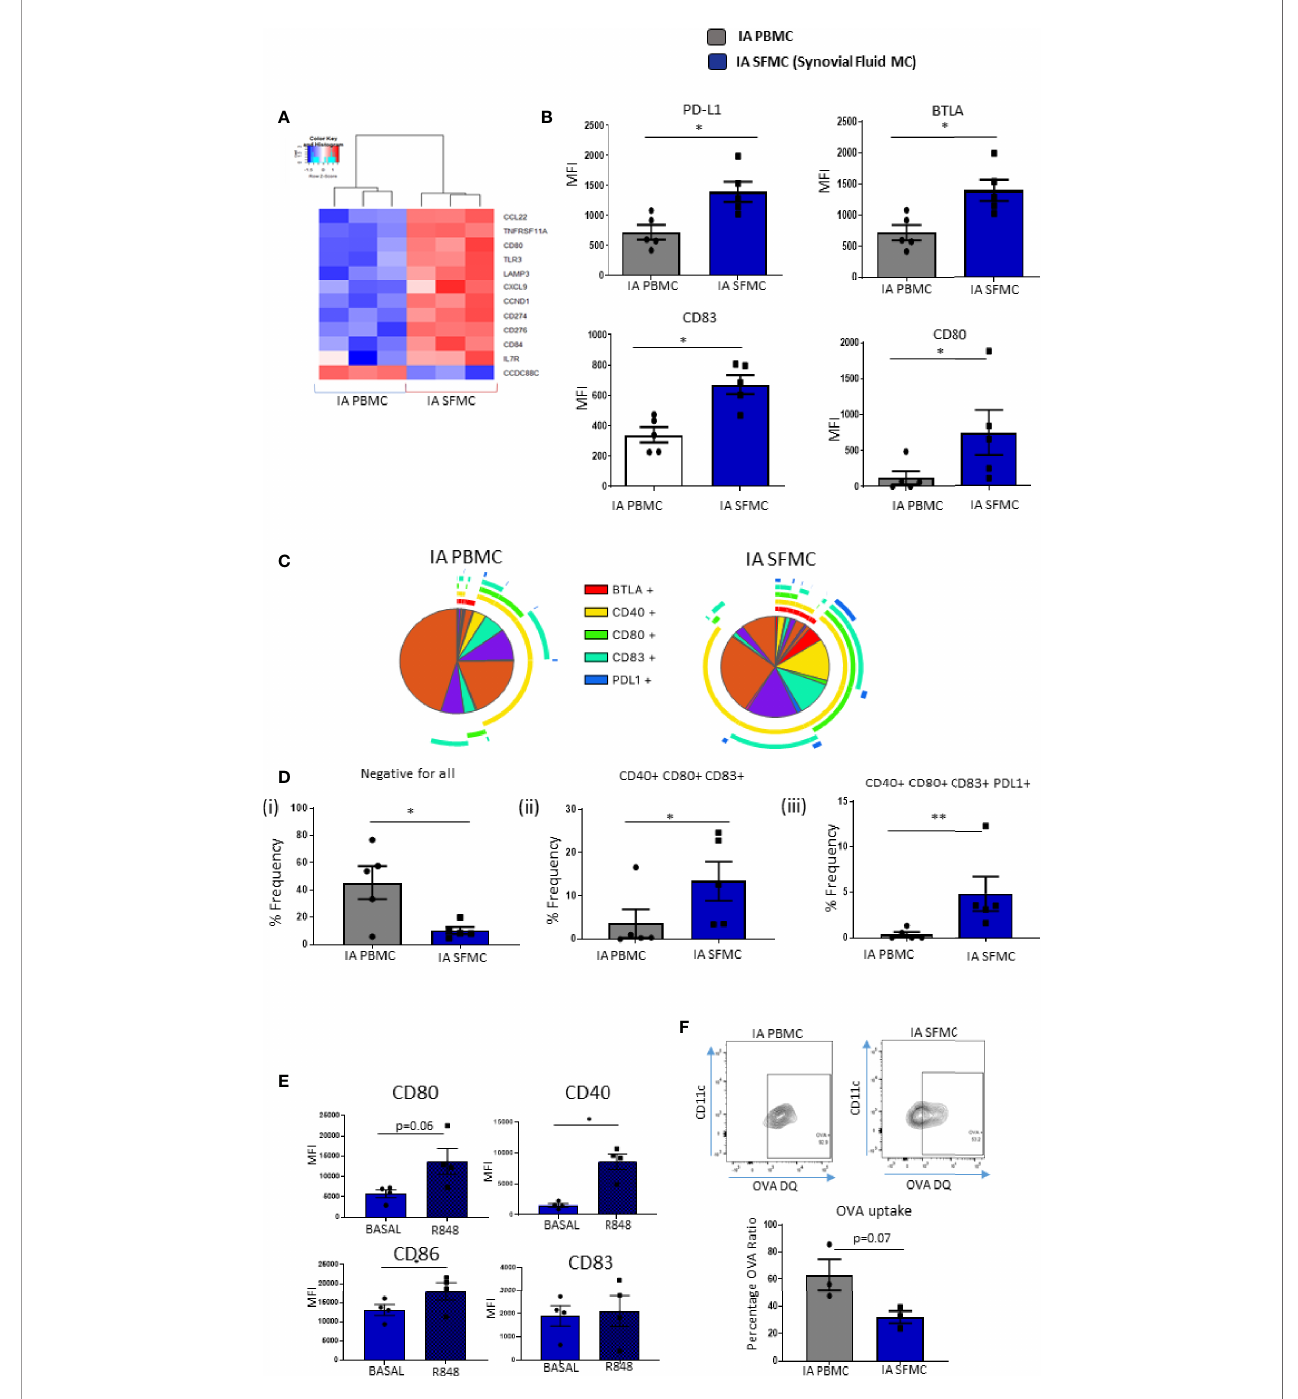
FIGURE 4 | Unique Costimulatory Marker Co-Expression on Synovial CD1c + DCs. (A) Clustered heatmap representing DEG involved in DC maturation from CD1c + DCs in IA PBMC and IA SFMC. (B) MFI of CD83, CD80, PD-L1, and BTLA on CD1c + DCs from IA (n = 5) and IA SFMC (n = 5). (C) SPICE analysis charts demonstrating the co-expression pro fi le of DC maturation markers on CD1c + DCs from IA PBMC and IA SFMC. Each section of the pie chart indicates different combinations of maturation marker. The pie chart arcs indicate the maturation markers expressed by each proportion of cells. (D) Percentage frequency of the most differentially distinct co-expression patterns from the SPICE analysis on CD1c+DCs from IA PBMC (n = 5) and IA SFMC (n = 5). (E) MFI of CD80, CD40, CD86, and CD83 expression on SF CD1c + DC unstimulated or stimulated for 18 h with R848 (1 µg/ml) (n = 4). (F) Percentage frequency of OVA-positive CD1c + DCs from IA PBMC and IA SFMC (n = 3) and representative fl ow cytometry dot plots. Non-parametric unpaired Mann Whitney test was used. Where multiple comparisons were determined, two-way ANOVA was used. *p < 0.05, **p < 0.01 indicate groups that are signi fi cantly different from each